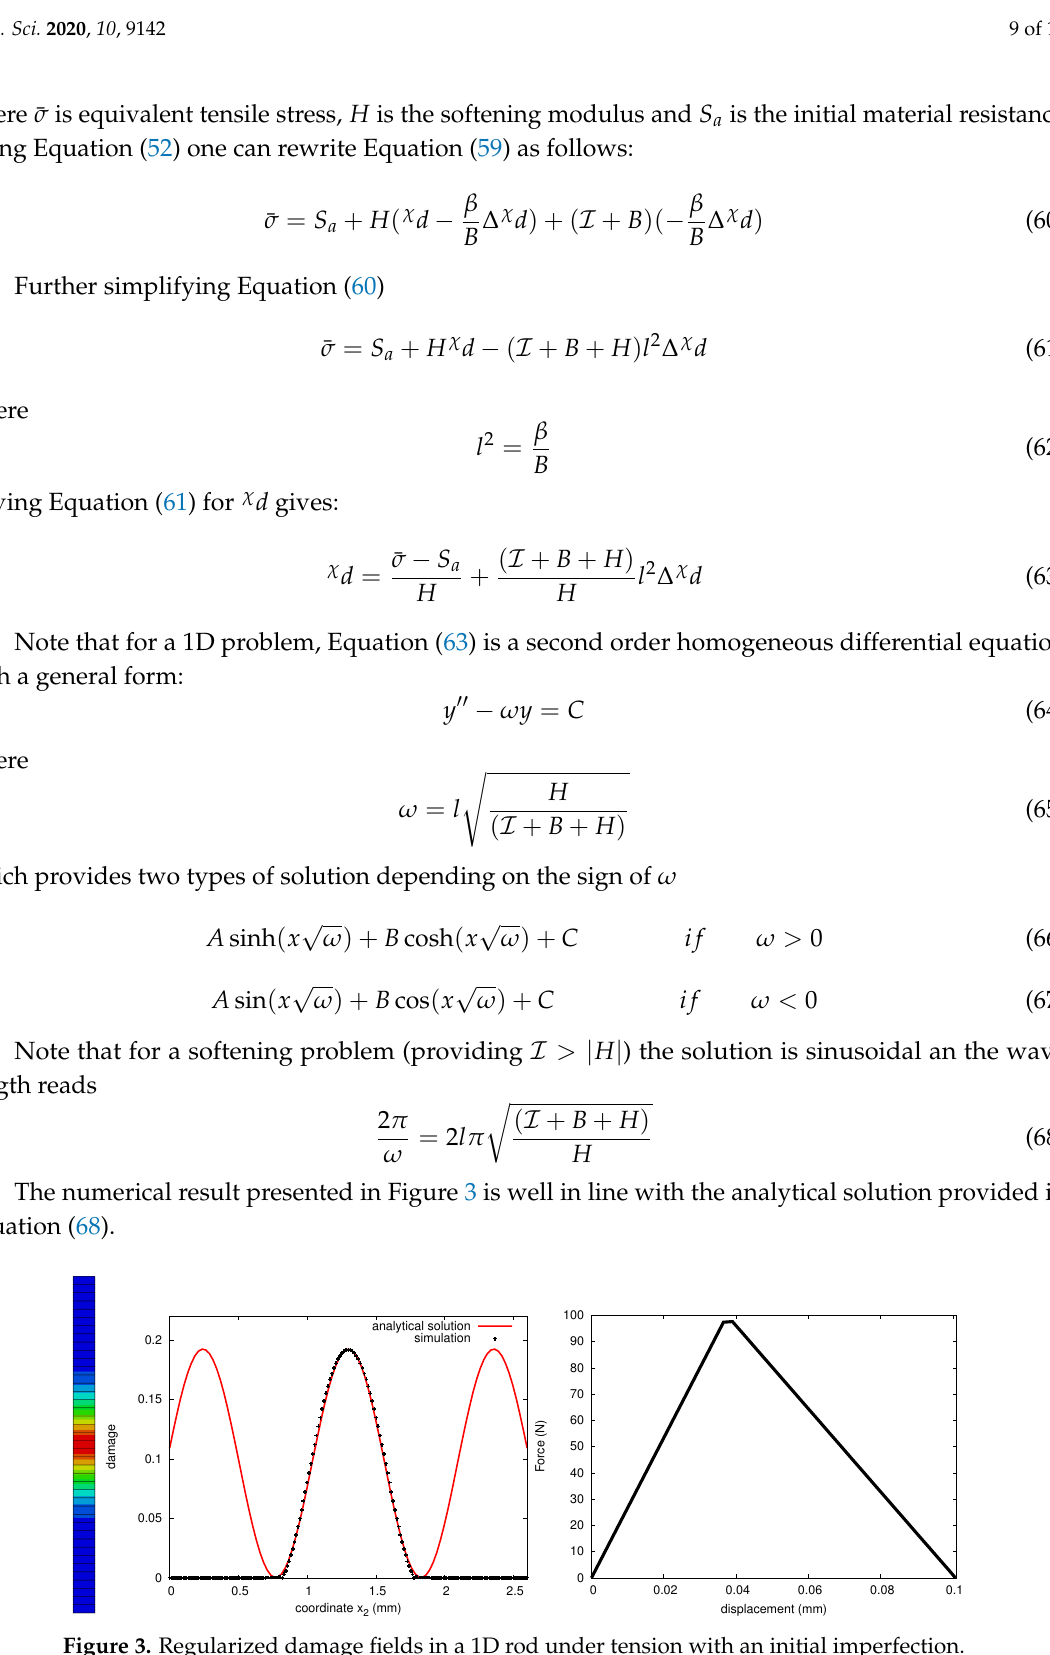
Figure 3. Regularized damage fields in a 1D rod under tension with an initial